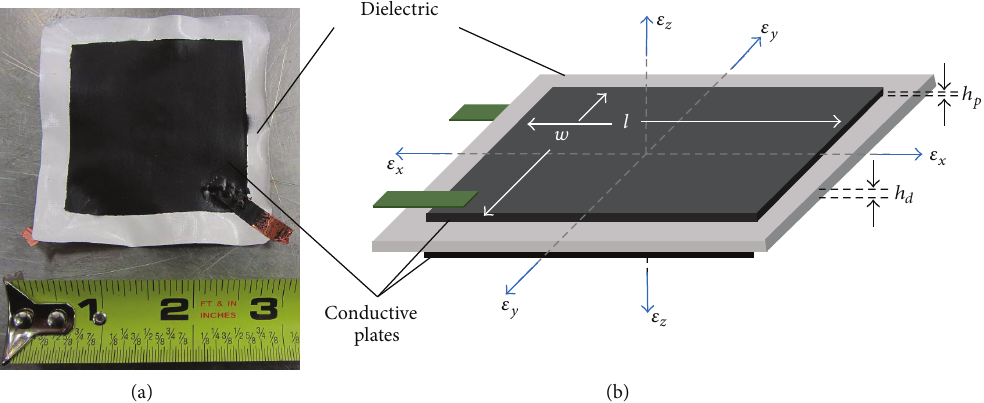
Figure 2: (a) A picture of a single SEC (76.2 × 76.2 mm 2 (3 × 3 in 2 )) and (b) schematic of SEC with principal axes.